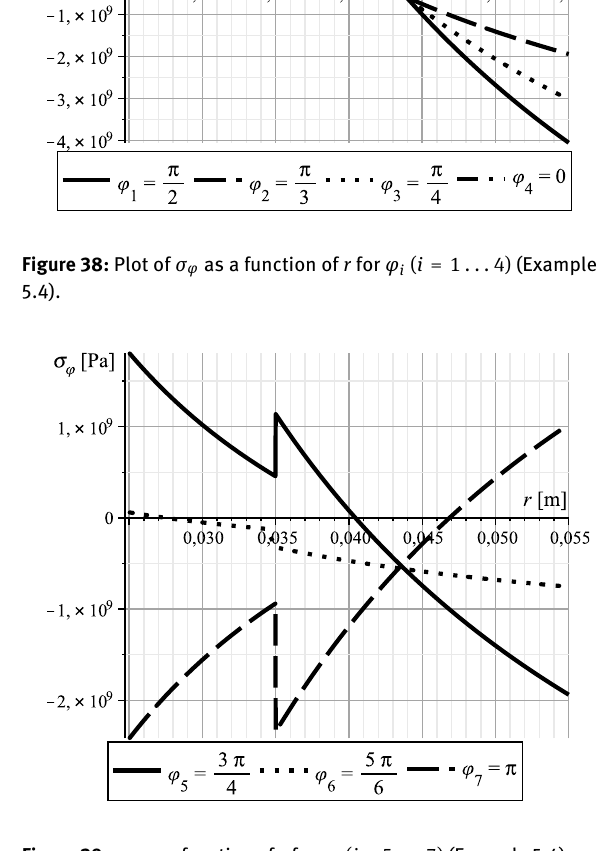
Figure 39: σ φ as a function of r for φ i ( i = 5 . . . 7) (Example 5.4).